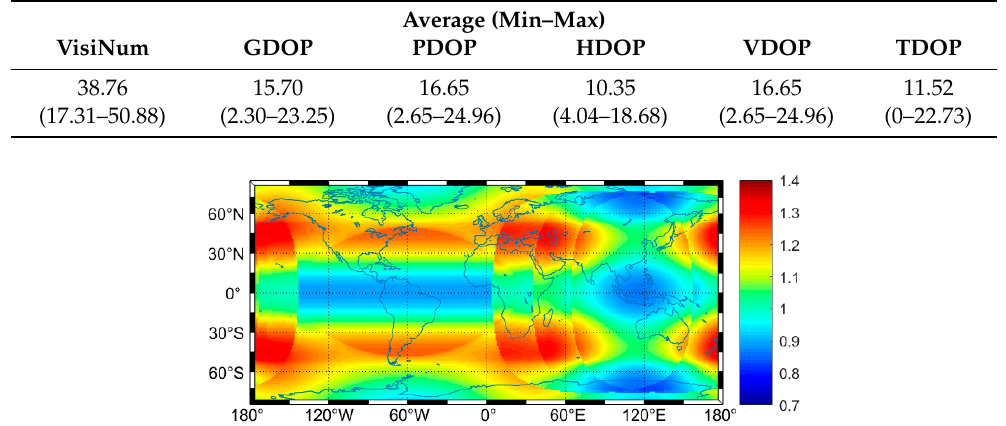
Table 7. Improvement rates (%) of introducing HEO satellites relative to BDS-3 at 30° N–90° N region.